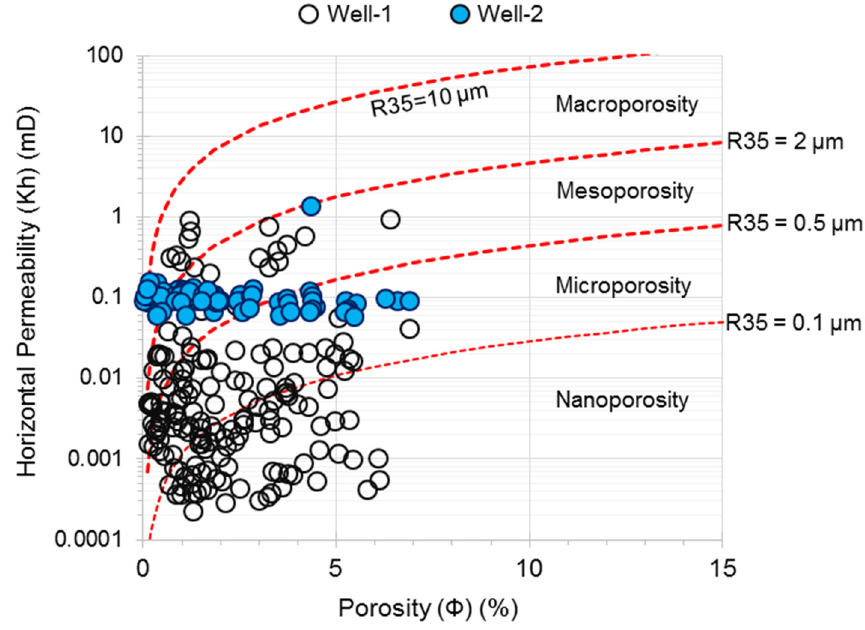
Figure 4. Cross plot between core-measured porosity and horizontal porosity indicating the domi- nance of nano- and microporosity within the studied Turonian carbonates.